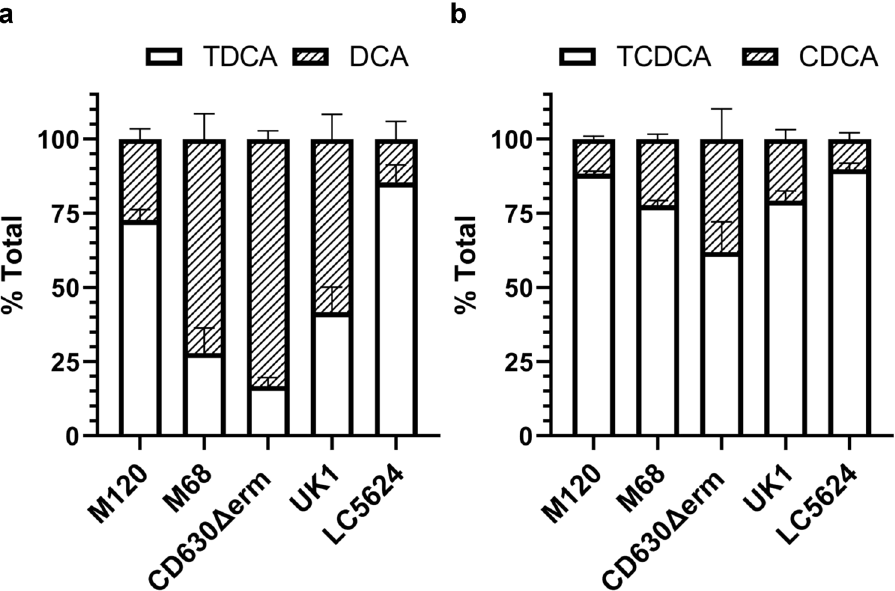
Fig. 3 C. dif fi cile deconjugates taurodeoxycholate and taurochenodeoxycholate. Deconjugation of taurodeoxycholate (TDCA) ( a ) or taurochenodeoxycholate (TCDCA) ( b ) by C. dif fi cile strains M120, M68, CD630 Δ erm, UK1, and LC5624 were determined as in Fig. 2. Values were calculated by measuring the peak areas for TDCA and DCA ( a ) or TCDCA and CDCA ( b ) and expressed as a percentage of total input. Hyodeoxycholate (HDCA) was included as an internal standard. Values shown are the average of three different independent experiments, and error bars represent the standard error of the